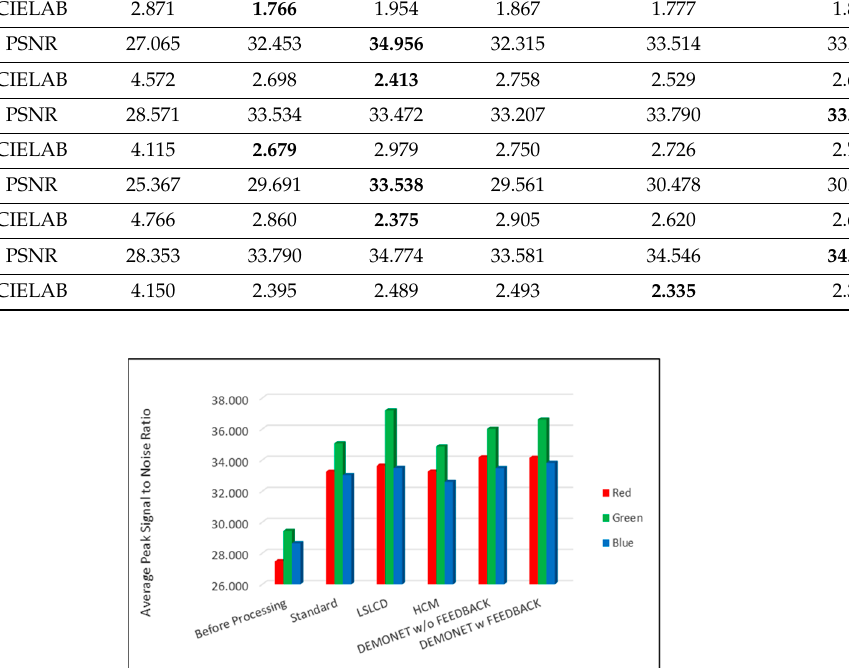
Figure 14. Averaged CIELAB values of different methods. Before Processing